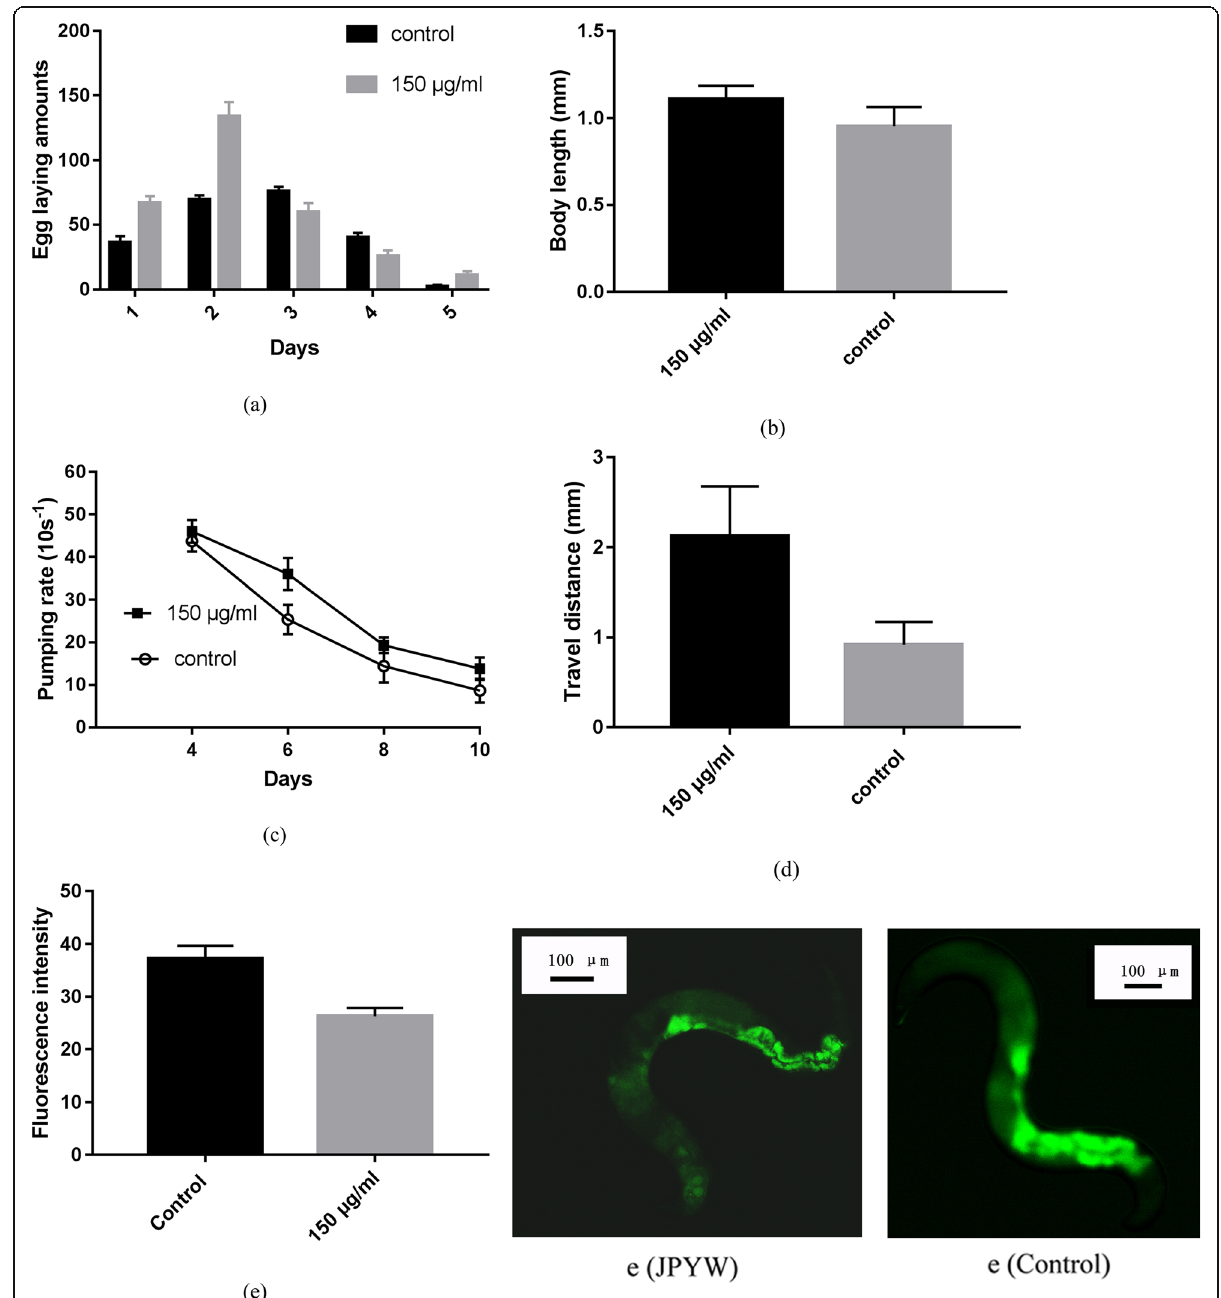
Fig. 4 Effect of JPYW on aging-related factors. a Daily and total reproductive outputs. The progeny were counted at the L2 or L3 stage. JPYW treatment significantly increased the total progeny number (297.4 ± 15.3 vs. 223.8 ± 6.3, n = 5, P < 0.01) compared to the control treatment. b For the growth alteration assay, photographs were taken of the worms, and the body length of each animal was analyzed. A small but significant change in body length was detected after JPYW treatment compared to the control treatment (0.953 ± 0.035 vs. 1.108 ± 0.024 mm, n = 10, P < 0.05). c JPYW slowed the decline in pharyngeal pumping during aging. Worms were treated with 150 μ g/ml JPYW and the pumping rates (pumps per 10 s) of 10 animals were scored in two trials (untreated vs. treated: day 6, P < 0.05; day 8, P < 0.05; day 10, P < 0.05; n = 10). d Body movement in wild-type N2 nematodes. Worm body movement was evaluated under a dissecting microscope for 20 s. The differences between the JPYW-treated worms and controls were significant (0.92 ± 0.08 vs. 2.13 ± 0.18 mm, n = 10, P < 0.01). e Fluorescence intensity of lipofuscin and autofluorescence on the 10th day of adulthood. Compared to that in control worms, the intestinal lipofuscin accumulation in JPYW-treated worms was reduced (37.29 ± 0.54 vs. 26.32± 0.35, n = 20, P <